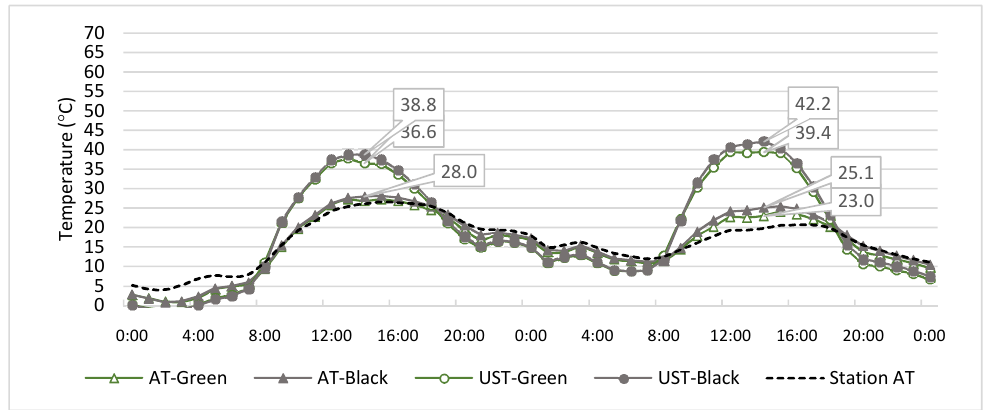
Figure 14. Thermal performance of AT-Green and UST-Green versus AT-Black and UST-Black.